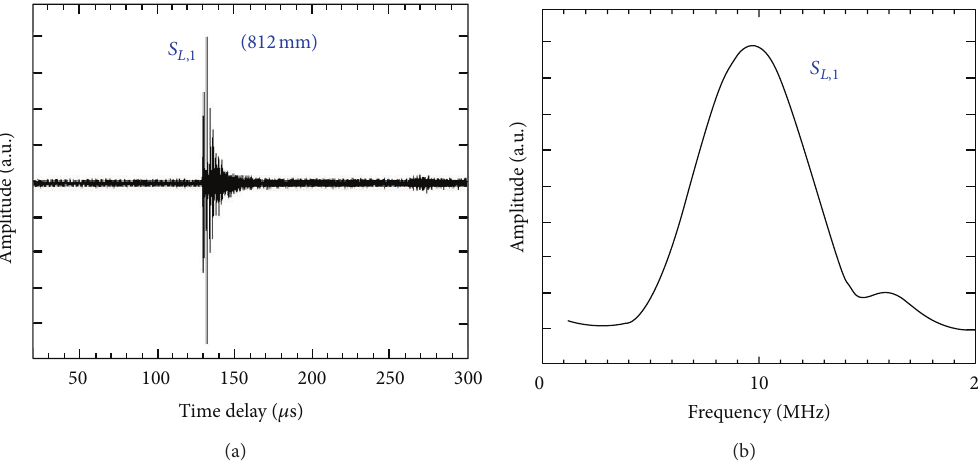
Figure 14: Measured reflected symmetrical PAW mode echoes from the edge opposite to the IUT (experiment performed with environment temperature of 150 ∘ C) in (a) time and (b) frequency domains.